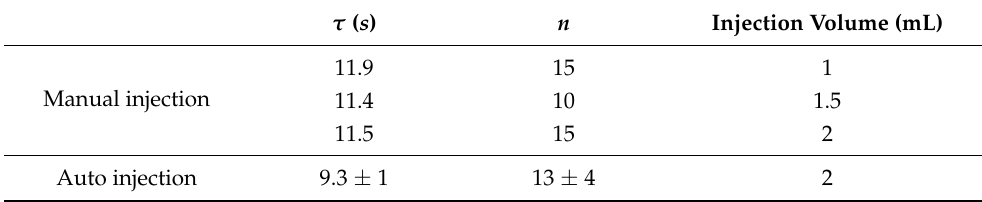
Table 2. CSTR fitting results for RTD measurement using different injection volume and